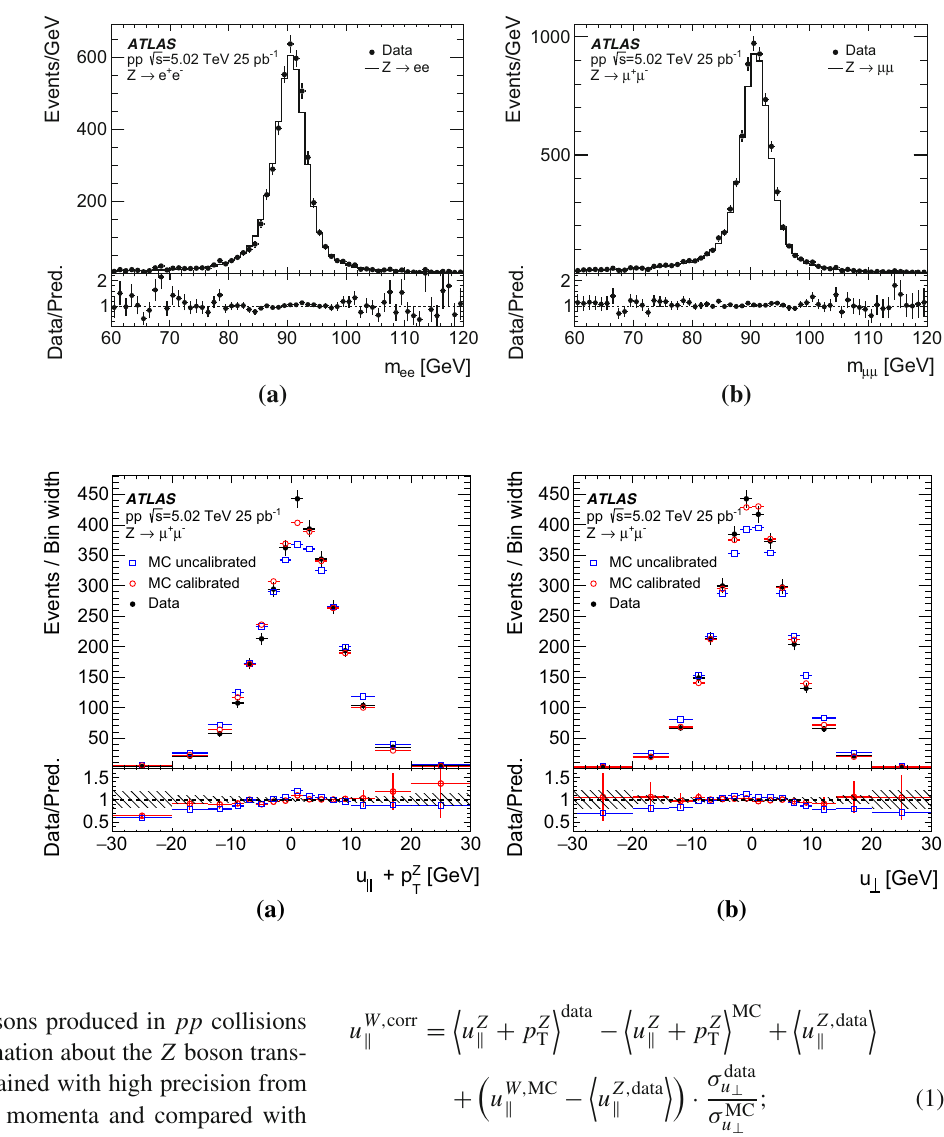
Fig. 2 Detector-level invariant mass distribution of a dielectron and b dimuon pairs from Z boson decays together with EW background contributions. Background contributions are too small to be visible on a linear scale. Only the statistical uncertainties of the data are shown